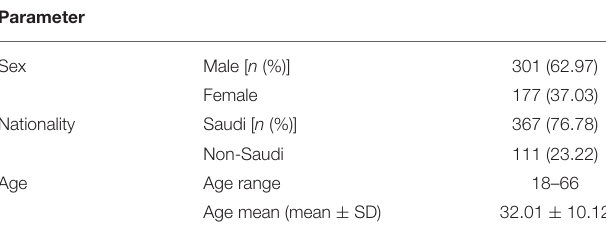
TABLE 1 | Demographic characteristics of study population ( n =